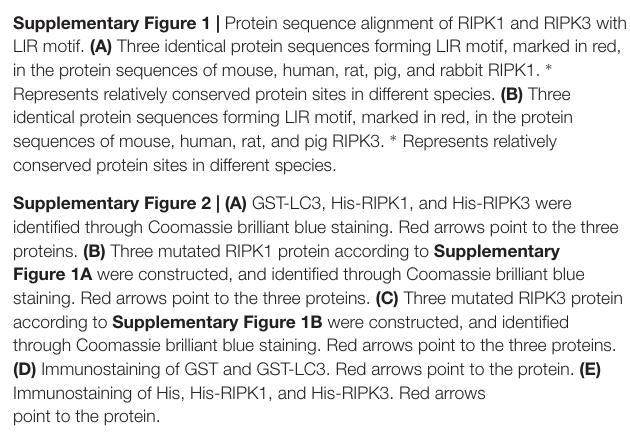
Supplementary Figure 1 | Protein sequence alignment of RIPK1 and RIPK3 with LIR motif. (A) Three identical protein sequences forming LIR motif, marked in red, in the protein sequences of mouse, human, rat, pig, and rabbit RIPK1. ∗ Represents relatively conserved protein sites in different species. (B) Three identical protein sequences forming LIR motif, marked in red, in the protein sequences of mouse, human, rat, and pig RIPK3. ∗ Represents relatively conserved protein sites in different species. Supplementary Figure 2 | (A) GST-LC3, His-RIPK1, and His-RIPK3 were identified through Coomassie brilliant blue staining. Red arrows point to the three proteins. (B) Three mutated RIPK1 protein according to Supplementary Figure 1A were constructed, and identified through Coomassie brilliant blue staining. Red arrows point to the three proteins. (C) Three mutated RIPK3 protein according to Supplementary Figure 1B were constructed, and identified through Coomassie brilliant blue staining. Red arrows point to the three proteins. (D) Immunostaining of GST and GST-LC3. Red arrows point to the protein. (E) Immunostaining of His, His-RIPK1, and His-RIPK3. Red arrows point to the protein. Supplementary Figure 3 | (A) Immunostaining of His and His-RIPK1(Mut2). Red arrows point to the protein. (B) Immunostaining of His, His-RIPK1(Mut1), and His-RIPK1(Mut3). Red arrows point to the protein. (C) Immunostaining of His, His-RIPK3(Mut1), His-RIPK3(Mut2), and His-RIPK3(Mut3). Red arrows point to the protein. (D,E) Input of Figure4i and Figure4j, respectively. (F,G) Input of Figure4k and Figure4l, respectively. Supplementary Figure 4 | (A,B) Western blotting and statistical analysis of RIPK1 from Ctrl + CMV, Ctrl+RIPK1-OE(Mut1) and Hypoxia + RIPK1-OE(Mut1). Mean ± SEM, n = 3. ∗∗∗ p < 0.001 versus the Ctrl + CMV group, ## p < 0.01 versus the Ctrl + RIPK1-OE(Mut1) group. (C,D) Western blotting and statistical analysis of RIPK1 from Ctrl + CMV, Ctrl + RIPK1-OE(Mut2) and Hypoxia + RIPK1-OE(Mut2). Mean ± SEM, n = 3. ∗∗∗ p < 0.001 versus the Ctrl + CMV group, # p < 0.05 versus the Ctrl + RIPK1-OE(Mut2) group. (E,F) Western blotting and statistical analysis of RIPK1 from Ctrl + CMV, Ctrl + RIPK1-OE(Mut3) and Hypoxia + RIPK1-OE(Mut3). Mean ± SEM, n = 3. ∗∗ p < 0.01 versus the Ctrl + CMV group, ns means no statistical difference versus the Ctrl + RIPK1-OE(Mut3) group. (G,H) Western blotting and statistical analysis of RIPK3 from Ctrl + CMV, Ctrl + RIPK3-OE(Mut1), and Hypoxia + RIPK3-OE(Mut1). Mean ± SEM, n = 3. ∗∗ p < 0.01 versus the Ctrl + CMV group, ns means no statistical difference versus the Ctrl + RIPK3-OE(Mut1) group. (I,J) Western blotting and statistical analysis of RIPK3 from Ctrl + CMV, Ctrl + RIPK3-OE(Mut2) and Hypoxia + RIPK3-OE(Mut2). Mean ± SEM, n = 3. ∗∗∗ p < 0.001 versus the Ctrl + CMV group, ns means no statistical difference versus the Ctrl + RIPK3-OE(Mut2) group. (K,L) Western blotting and statistical analysis of RIPK3 from Ctrl + CMV, Ctrl + RIPK3-OE(Mut3) and Hypoxia + RIPK3-OE(Mut3). Mean ± SEM, n = 3. ∗∗ p < 0.01 versus the Ctrl + CMV group, ns means no statistical difference versus the Ctrl + RIPK3-OE(Mut3) group. Supplementary Figure 5 | (A–C) Western blotting and statistical analysis of ATG5, LC3, RIPK1, RIPK3, p-RIPK3, MLKL and p-MLKL from Ctrl + CMV, Ctrl + ATG5-OE, and Ctrl + ATG5-OE groups. Mean ± SEM, n = 3. ∗ p < 0.05, ∗∗ p < 0.01, ∗∗∗ p < 0.001 versus the Ctrl + CMV group, # p < 0.05 and ## p < 0.01 versus the Ctrl + ATG5-OE group. (D) LDH leakage analysis was performed to determine cell death of corresponding groups in panel (A) . Mean ± SEM, n =